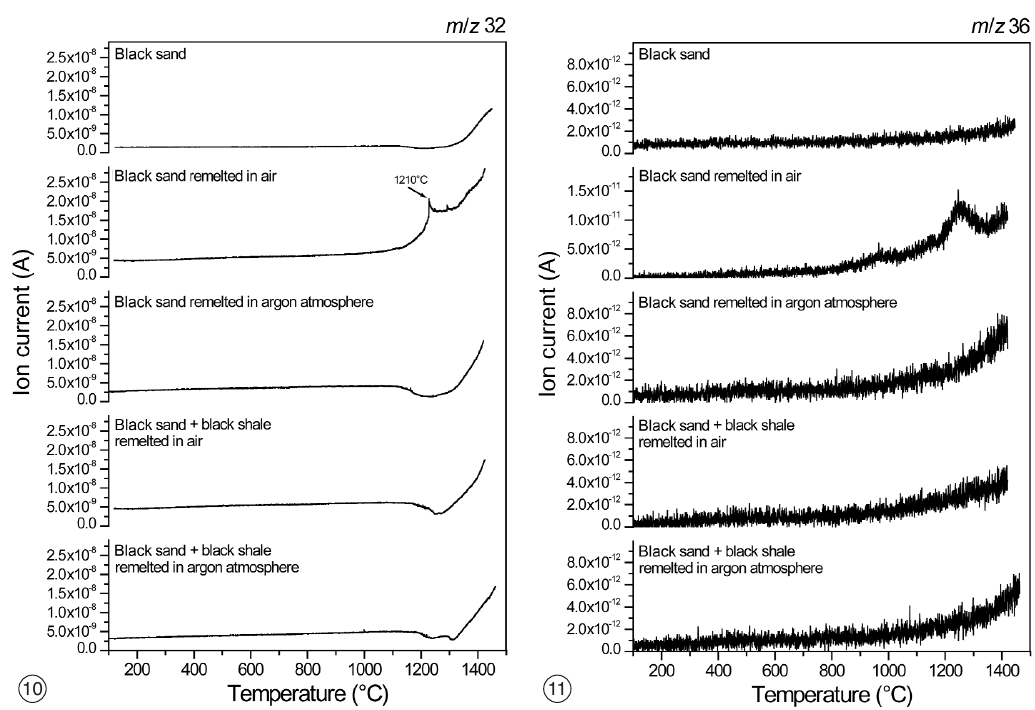
Fig. 10. Change of the partial pressure of mass number m / z = 32 (O 2 + ). Fig. 11. Change of the partial pressure of mass number m / z = 35 ( 35 Cl +